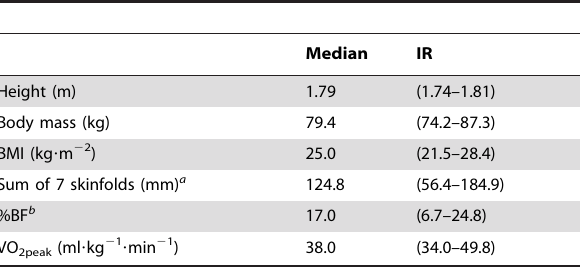
Table 1. Characteristics of the subjects (n=